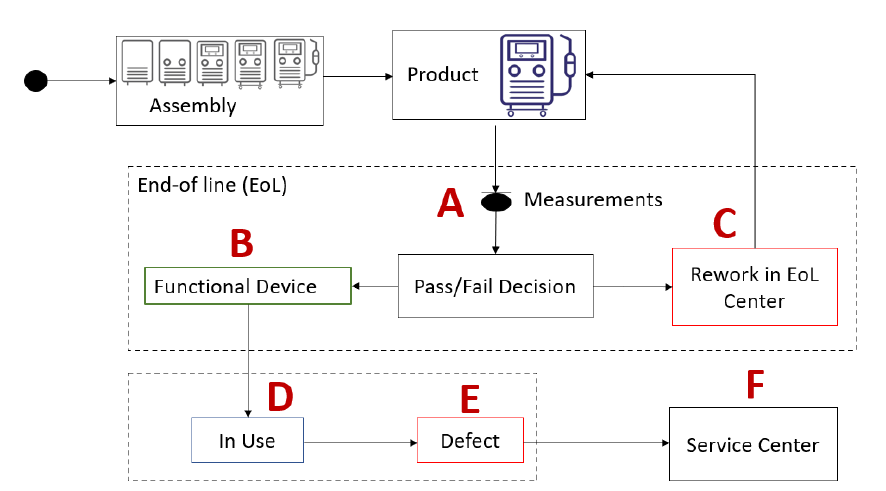
Figure 9. An overview of EoL testing process, reproduced with the permission of [86], Elsevier,